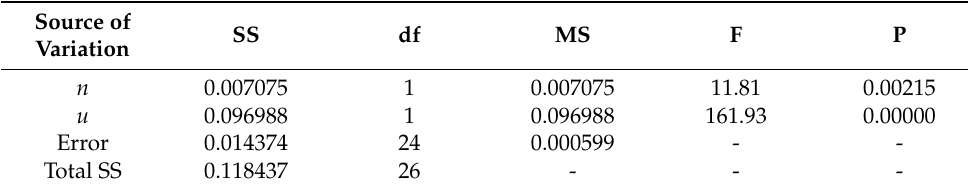
Table 9. Model of density ρ —ANOVA table. R 2 = 0.88; R adj2 = 0.87.